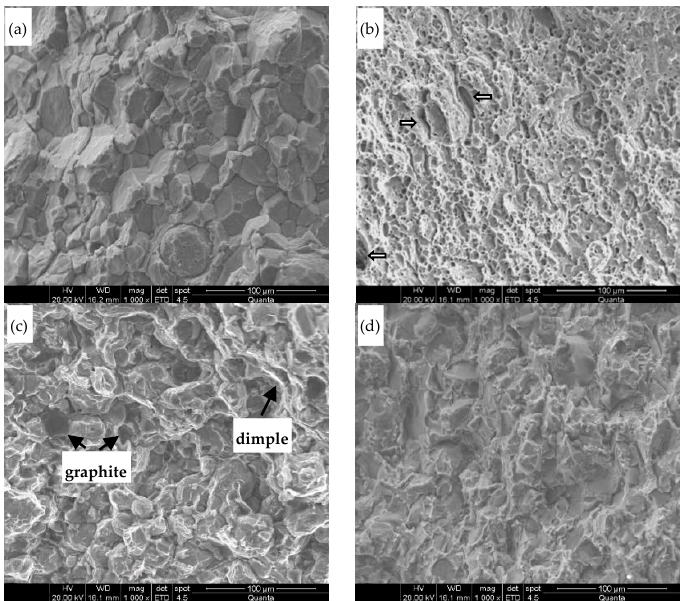
Figure 8. Fracture surfaces of ( a , b ) the 0 vol.% UHP and HP-sintered, and ( c , d ) that of the 5 vol.% G/6061Al corresponding.